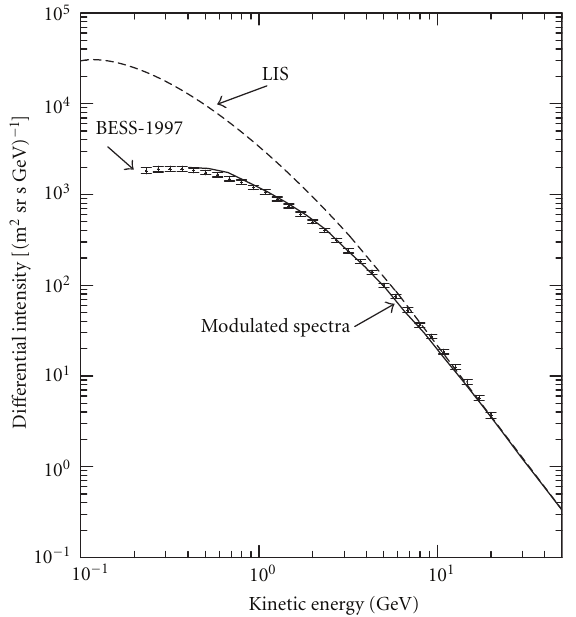
F 4: Proton differential intensity determined with the HelMod code (continuous line) compared to the experimental data of BESS- 1997; the dashed line is the LIS (see the text).